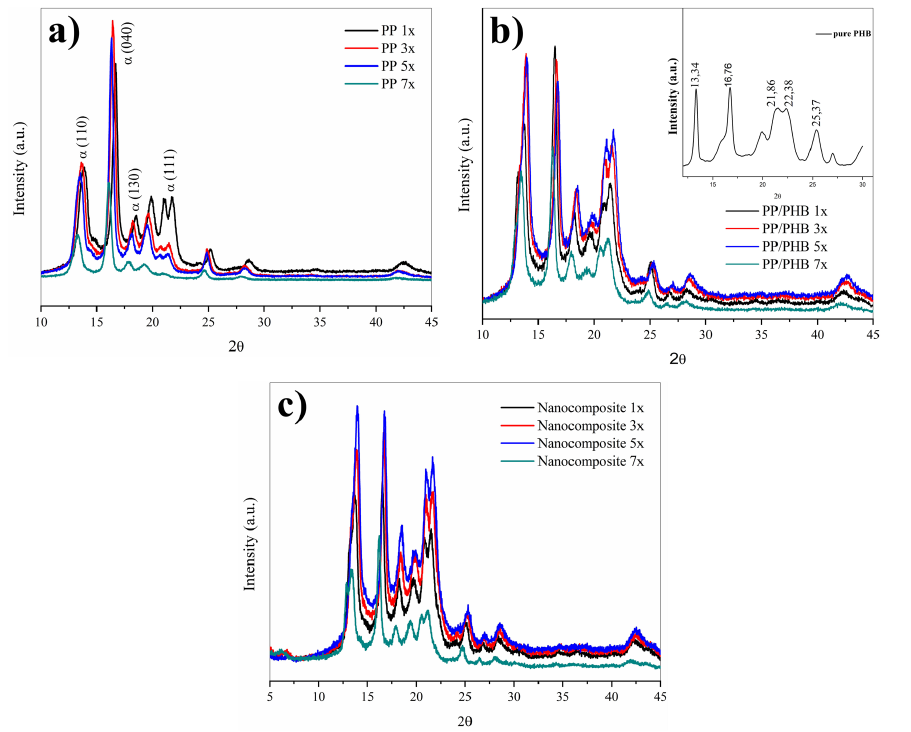
Figure 3. XRD patterns of pure PP, the PP/PHB blend and the PP/PHB/MMO/gMA/Eru nanocomposite after each reprocessing Table 1. Effects of reprocessing cycles on the degree of crystallinity of the systems investigated. Cycle